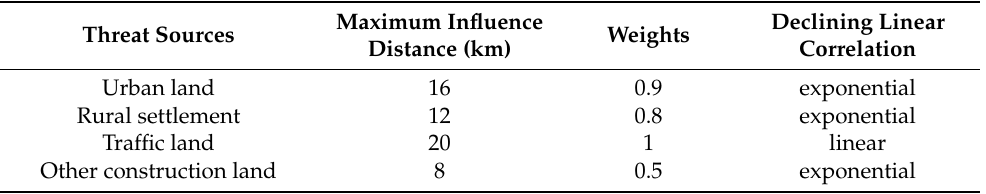
Table A1. Detailed information of the threat sources applied in the InVEST